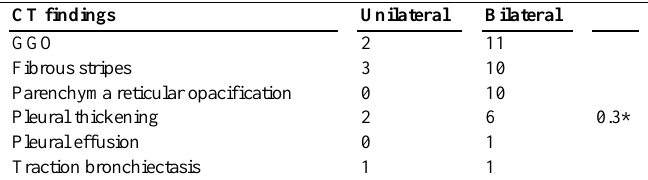
Table 3: Distribution of residual CT scan findings; Unilateral versus bilateral